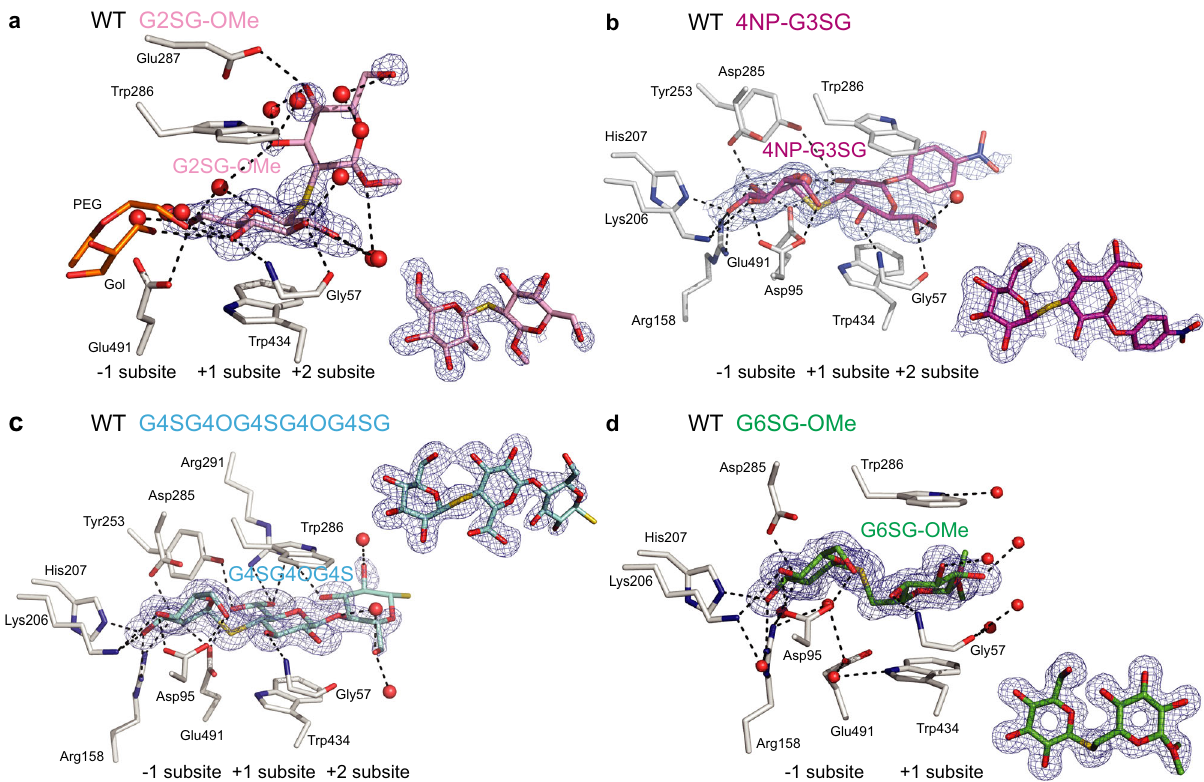
Fig. 2 | WT HvExoI in complex with thio-saccharide analogues. a Thio- sophoroside (G2SG-OMe; pink); b thio-laminaribioside (4NP-G3SG; magenta); c thio-cellotrioside (G4SG4OGS; cyan); and d thio-gentiobioside (G6SG-OMe; green)moietiesareboundacrossthe − 1to+2subsites.Panels a to d containderived difference2m| F o |-D| F c | electron density maps(blue)of thio-analogues(also shown